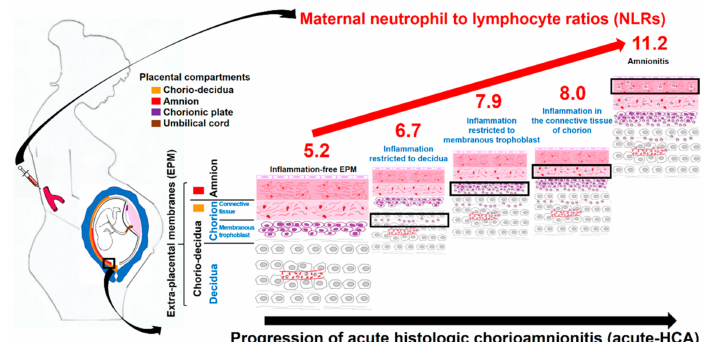
Figure 4. Schema of maternal neutrophil to lymphocyte ratios (NLRs) according to the progression of acute histologic chorioamnionitis